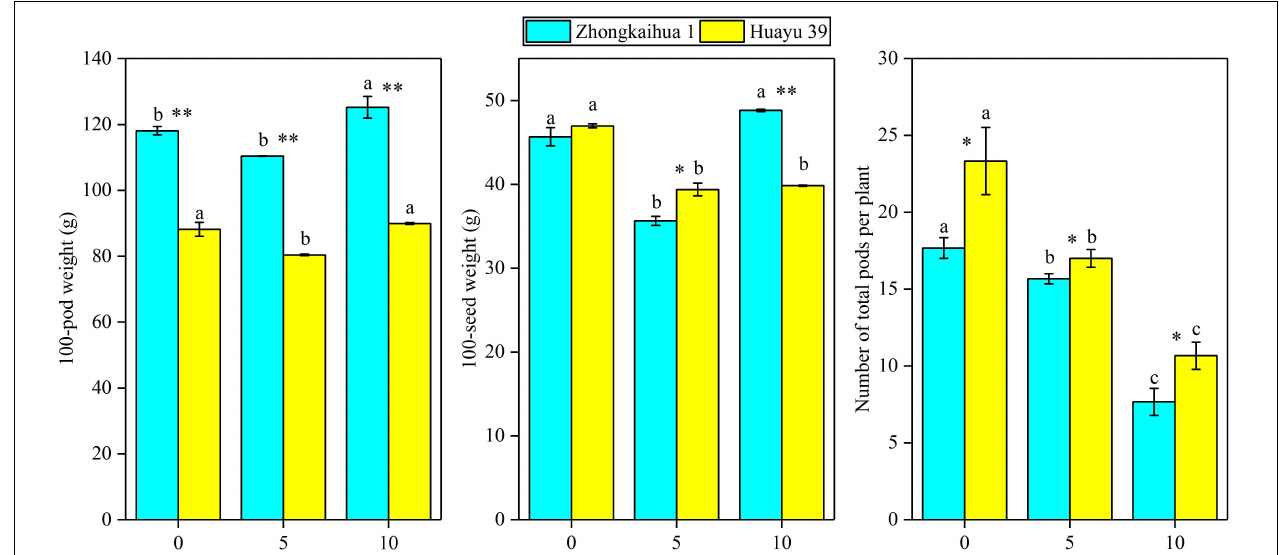
FIGURE 10 | Effects of waterlogging stress on the yield components of peanut plant. Data represent the mean ± standard error. Letters a and b after the value represent statistically significant differences ( p < 0.05) within a variety under different waterlogging treatments as determined by the least significant difference test. Significant differences at * p < 0.05 and ** p < 0.01 between Zhongkaihua 1 (ZKH 1) and Huayu 39 (HY 39) under the same